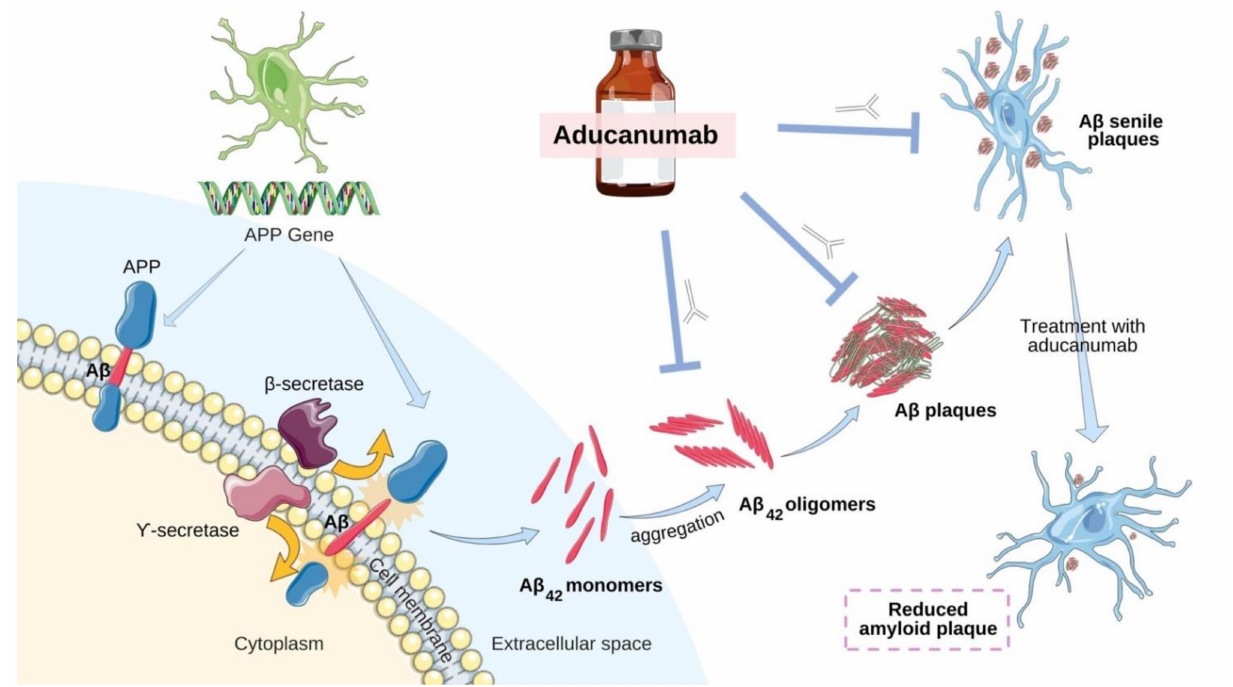
Figure 1. A β aggregation pathway and mechanism of action of aducanumab. APP is cleaved by β -secretase and γ -secretase to form A β 42 monomers, oligomers, and eventually senile plaques (note that protofibrils and fibrils are not illustrated in this figure); these are targets for clearance by aducanumab resulting in reduced amyloid burden. Parts of the figure were illustrated using images from Servier Medical Art by Servier, licensed under a Creative Commons Attribution 3.0 Unported License (https://creativecommons.org/licenses/by/3.0/ (accessed on 10 November